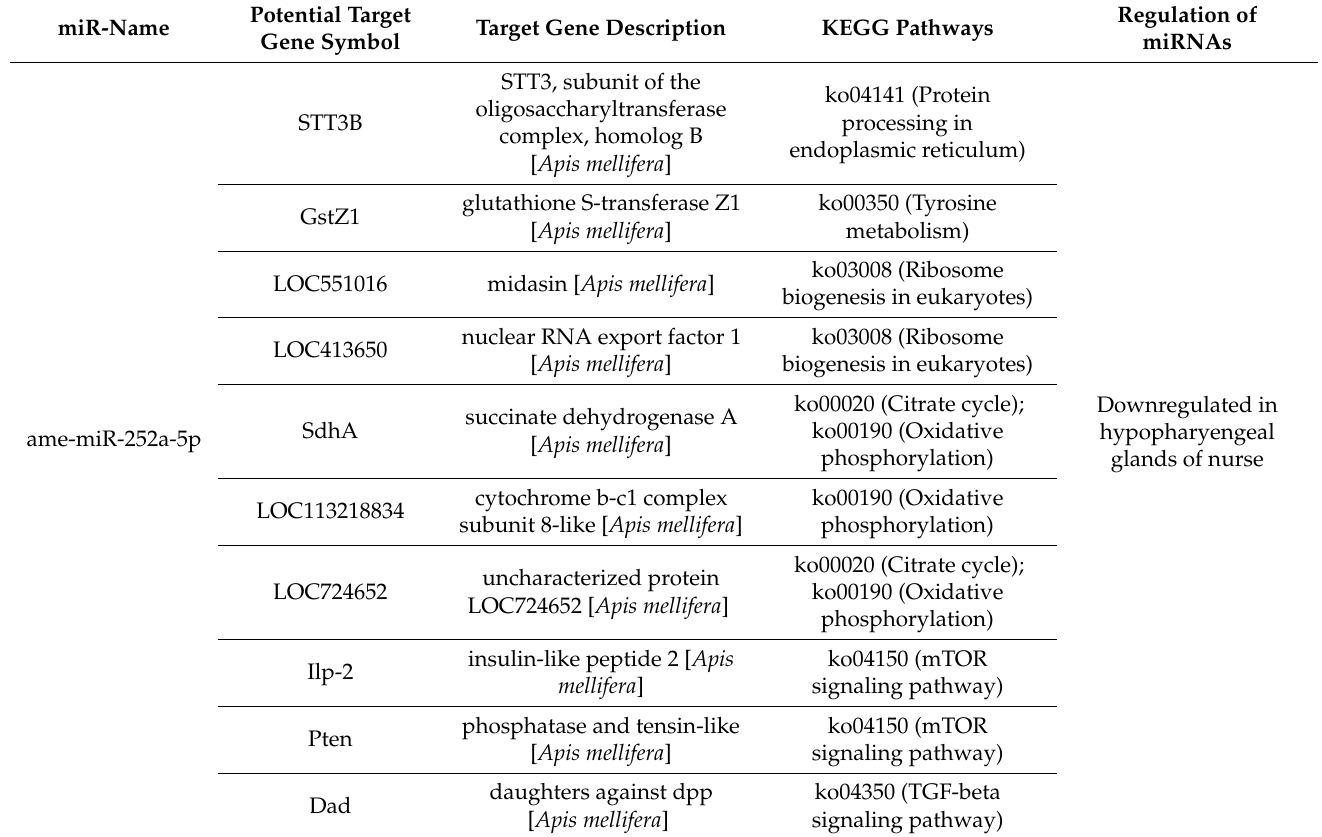
Figure 3. Differentially expressed miRNAs among nurse bee (NB), forager bee (FB), and newly- emerged bee (NEB) libraries. Table 4. The notable potential target genes of five selected differentially expressed